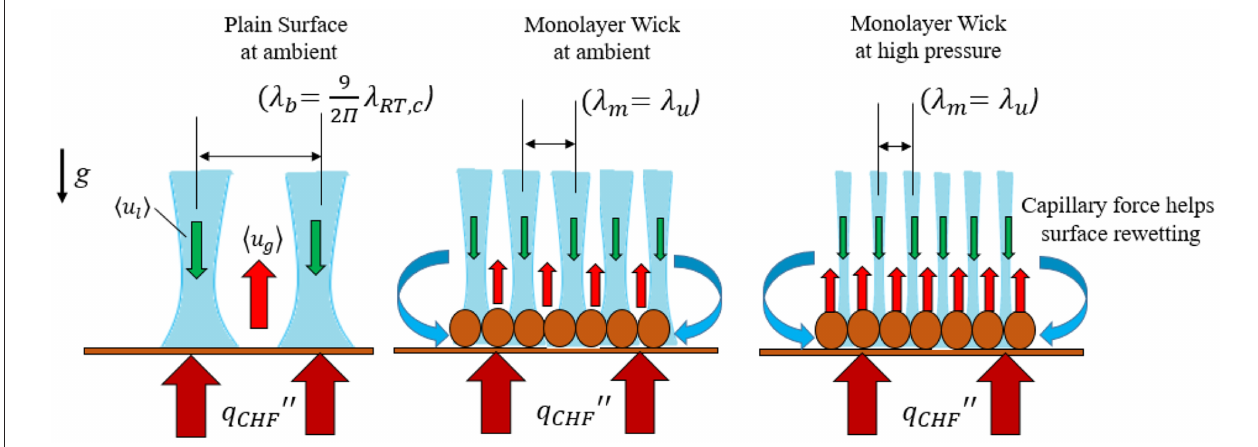
FIGURE 9 | Comparison of high-pressure pool-boiling mechanism for the plain surface and the single-layer wick surface. The critical heat flux, wick geometries, counter flow of the liquid-vapor jets, hydrodynamic instability wavelength are also shown. The role of capillary force in rewetting the wick surface is